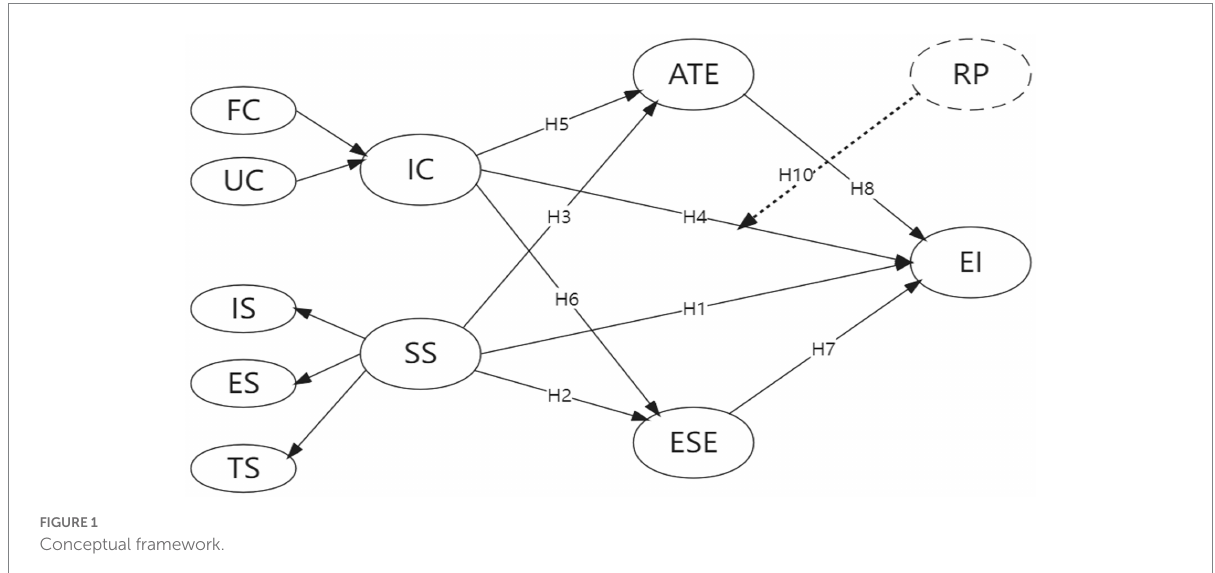
FIGURE 1 Conceptual framework.